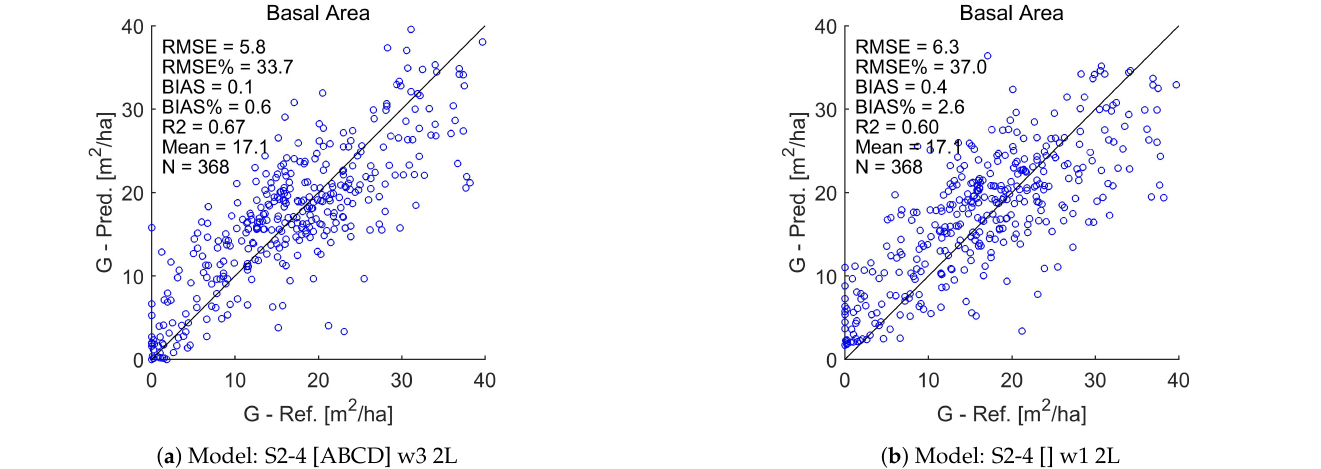
Figure A1. Scatterplots of basal area (G) test data set predictions with the proposed model concept ( a ) and with the simple model ( b